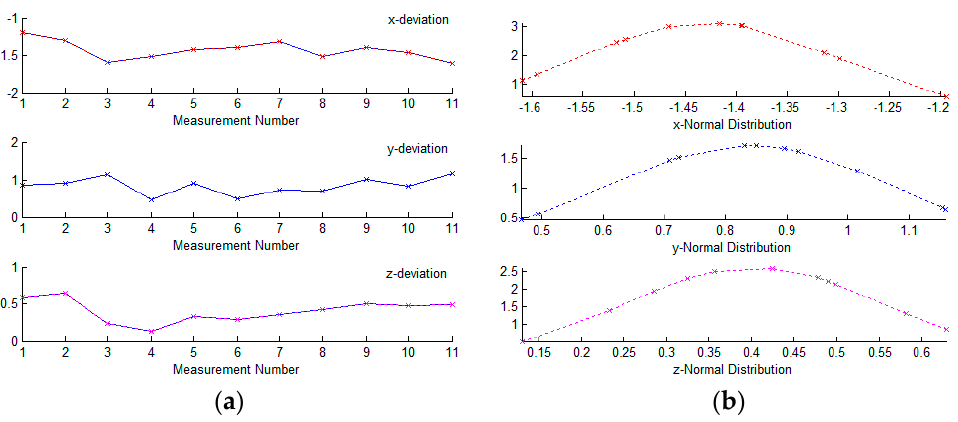
Figure 6. Deviations between measured values of hybrid visual system and Coordinate Measuring Machine (CMM): ( a ) 10 origin datums of a hole; ( b ) The corresponding normal distribution fitting.